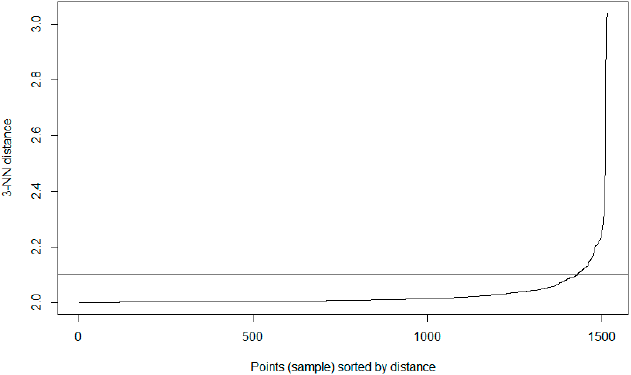
Figure 6. K -nearest neighbour (KNN) eps calculation plot.